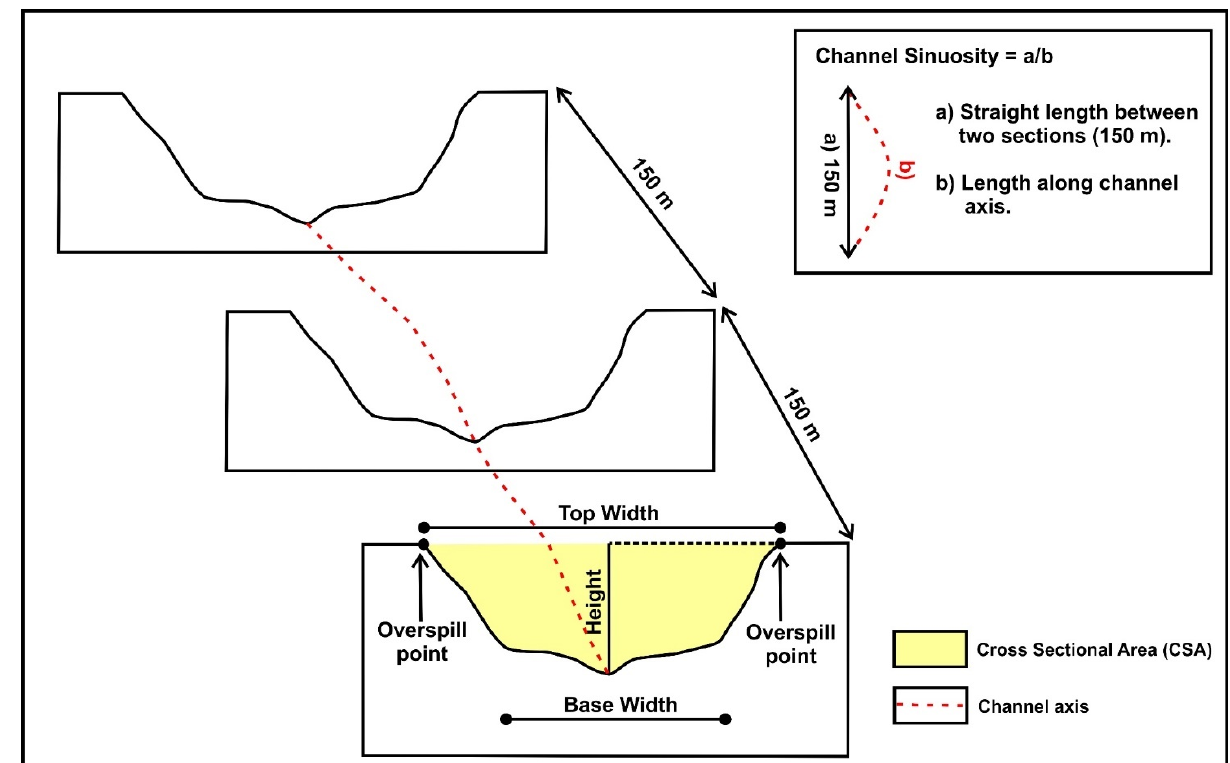
Figure 7. Morphometry elements of the channel’s complexes that were analyzed in this study.